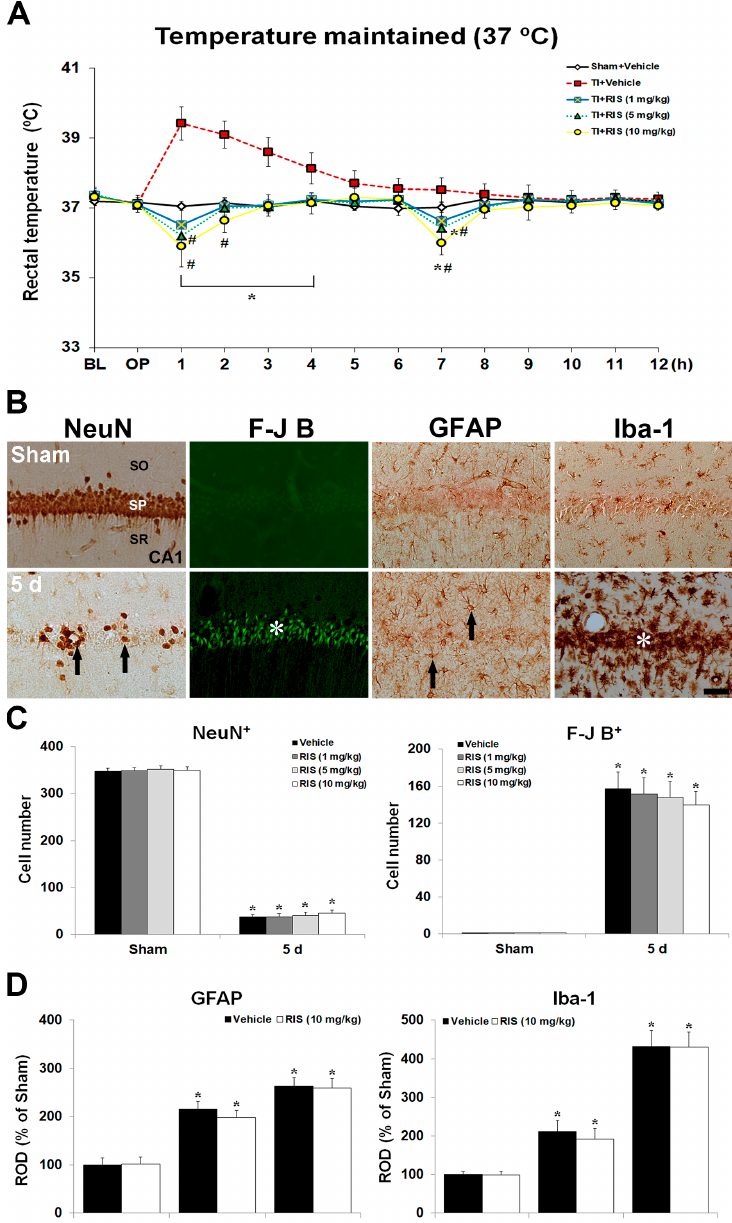
Figure 3. Effects of RIS against TI injury under controlled body temperature (CBT) condition. ( A ) Changes in body temperature under CBT condition for 12 h after TI. Body temperature is slightly low in the TI + 10 mg/kg RIS group compared to the TI + 5 mg/kg RIS group. White arrows indicate times of RIS treatment. The bars indicate the means ± SEM, n = 7/group, two-way analysis of variance (ANOVA) with a post-hoc Bonferroni’s multiple comparison test (* p < 0.05 vs. sham + vehicle group; # p < 0.05 vs. TI + vehicle group). ( B ) Effect of RIS (10 mg/kg) on NeuN + , F-J B + , GFAP + , and Iba-1 + cells in the CA1 under CBT after TI 5 days after TI. In the TI + RIS group, a few NeuN + neurons (arrows) and many F-J B + cells (asterisks) are shown in the stratum pyramidale (SP) at 5 days after TI. GFAP + astrocytes (arrows) and Iba-1 + microglia (asterisks) are markedly increased in the TI + RIS group under CBT 5 days after TI. SO, stratum oriens; SP, stratum pyramidale; SR, stratum radiatum. Scale bar = 50 μ m. Quantitative analyses of NeuN + and F-J B + cells ( C ), and GFAP + and Iba-1 + cells ( D ). The bars indicate the means ± SEM, n = 7/group, two-way analysis of variance (ANOVA) with a post-hoc Bonferroni’s multiple comparison test (* p < 0.05 vs. sham + vehicle group).